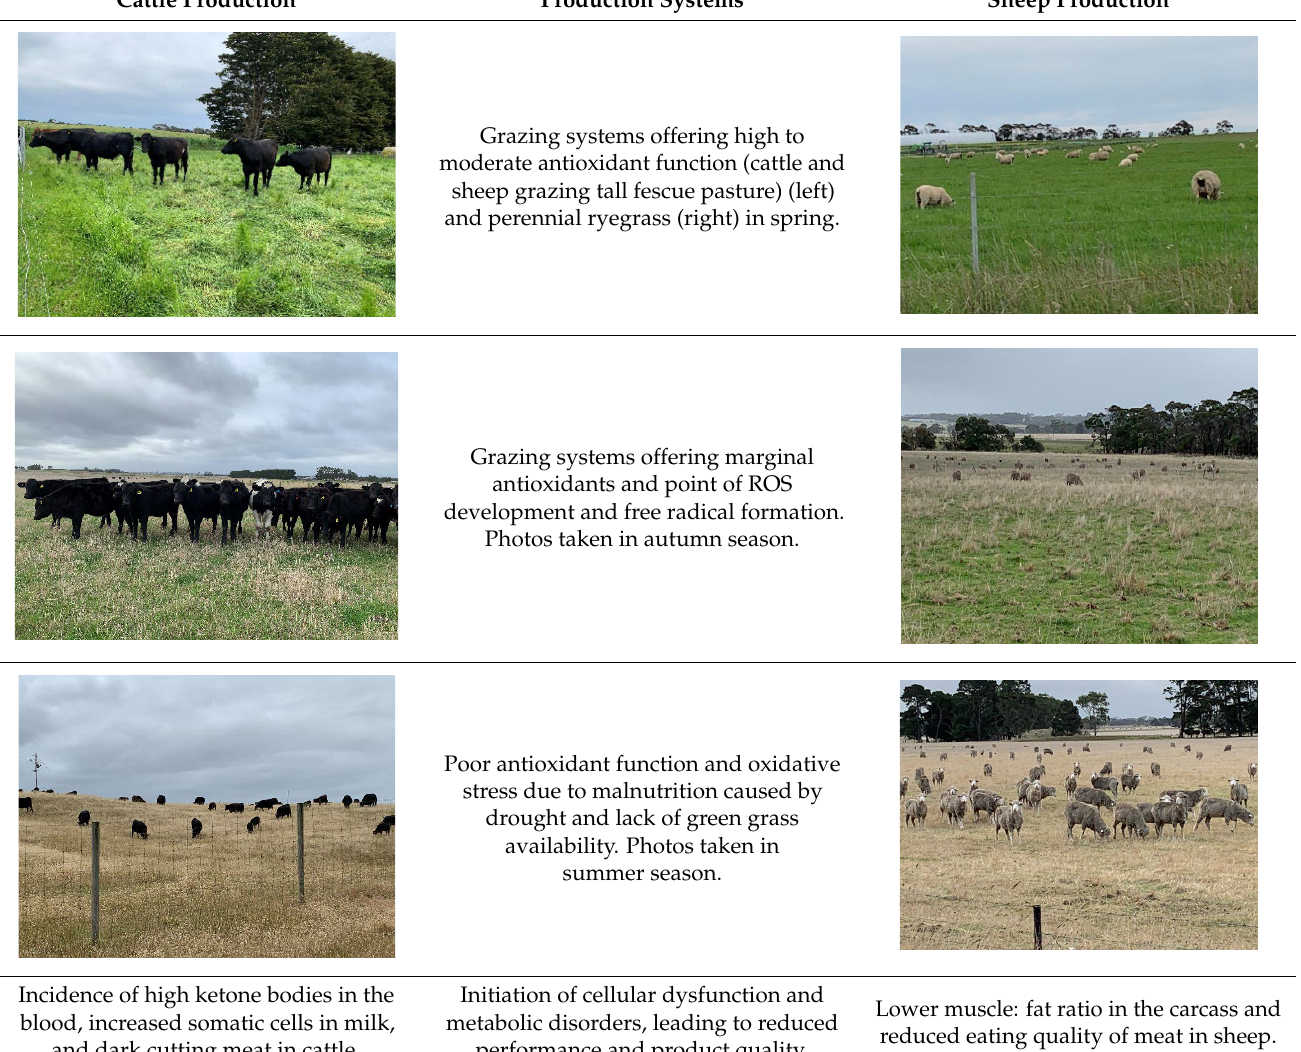
Table 2. Production systems offering different status of antioxidant function and oxidative stress.